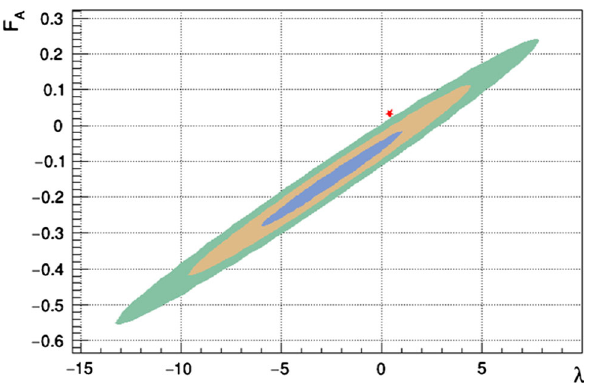
Fig. 8 ( F V , λ ) correlation plot. F V ( 0 ) is taken from theory. Red